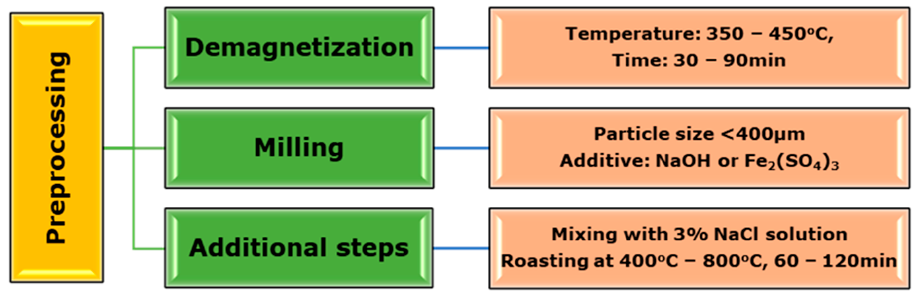
Figure 3. Proposed main steps of the NdFeB magnets